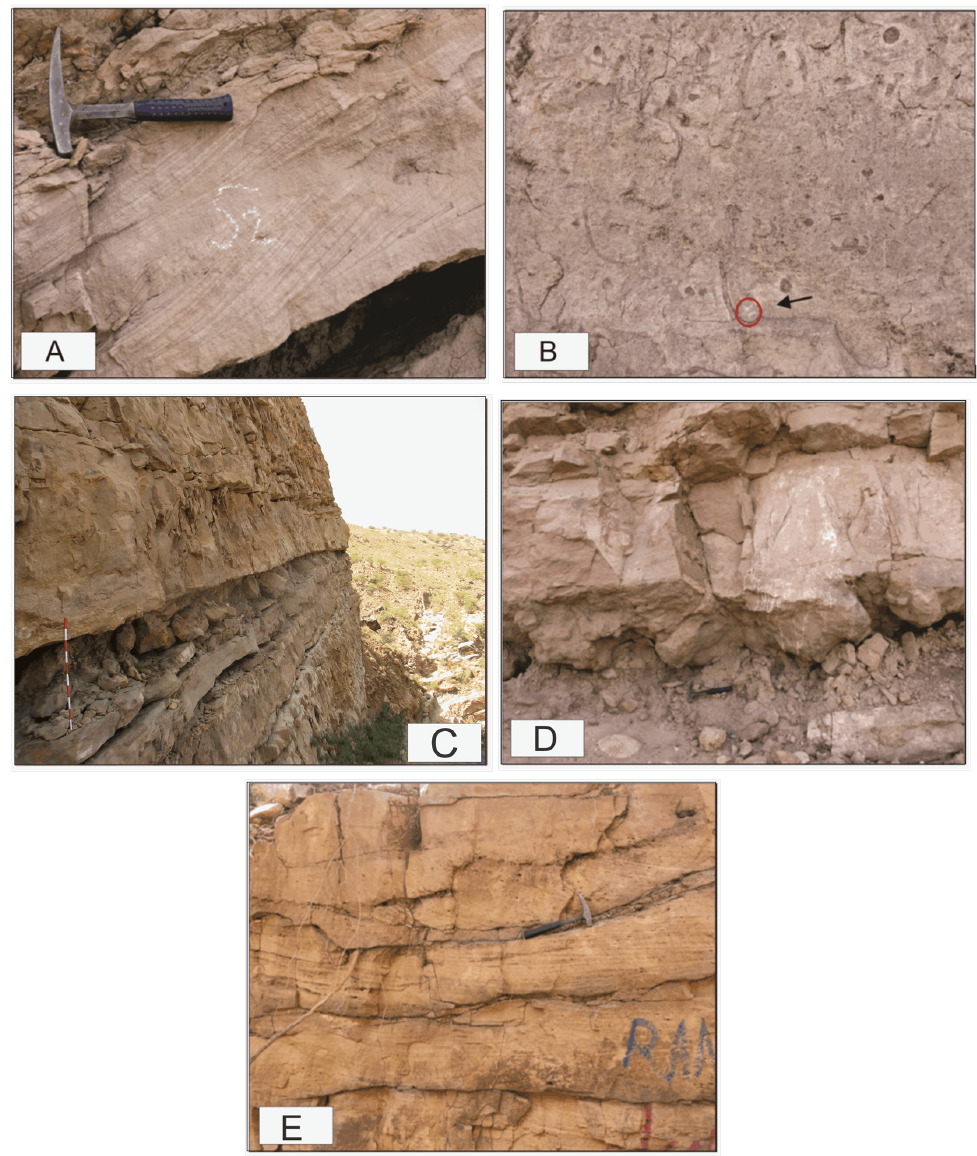
Figure 8. ( A ) Sedimentary cross bed representing fluvio-deltaic facies; ( B ) highly bioturbated bed red arrow associated with shelfal delta lobe; ( C ) shale unit highlighted by the meter stick of the delta front; ( D ) load cast belonging to channels; and ( E ) trough cross-bedded sandstone belonging to shore face environment.